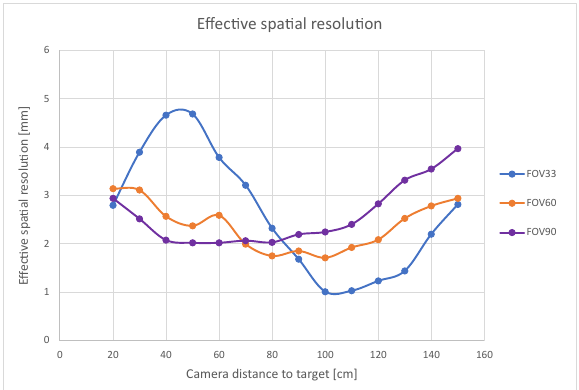
Figure 12. Effective spatial resolution in relation to target distance. has the best (effective) spatial resolution, MTF10 measurements can be translated to ground resolved distance (GRD, see Sec. 4.1) using the focal length and pixel size. Results are given in Figure 12. Even though the FOV 33 ◦ lens has the largest focal distance and therefore the best (theoretical) ground sample dis- tance, it can be seen that the narrow depth of field inhibits this advantage and GRD only is better in close surrounding of the operating distance. GRD of the FOV 60 ◦ and FOV 90 ◦ lenses are only short behind and do not change rapidly when moving away from the operating